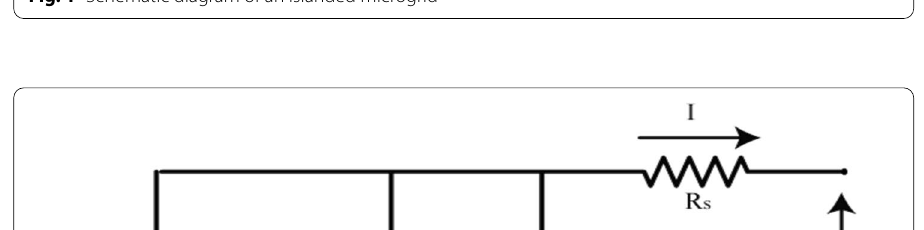
Fig. 1 Schematic diagram of an islanded microgrid